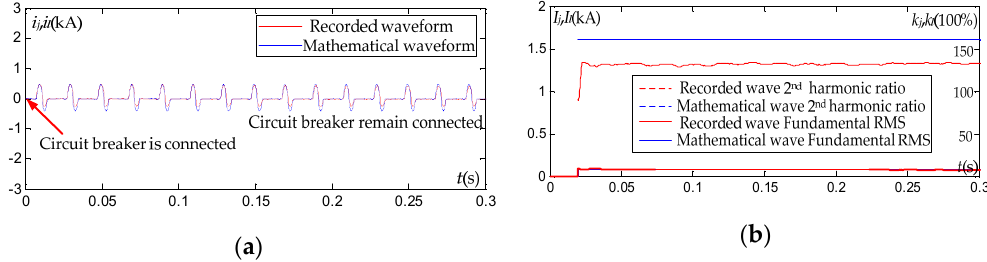
Figure 4. Graphical representation for waveform Number One: ( a ) original waveform; ( b ) fundamental RMS and second harmonic ratio.